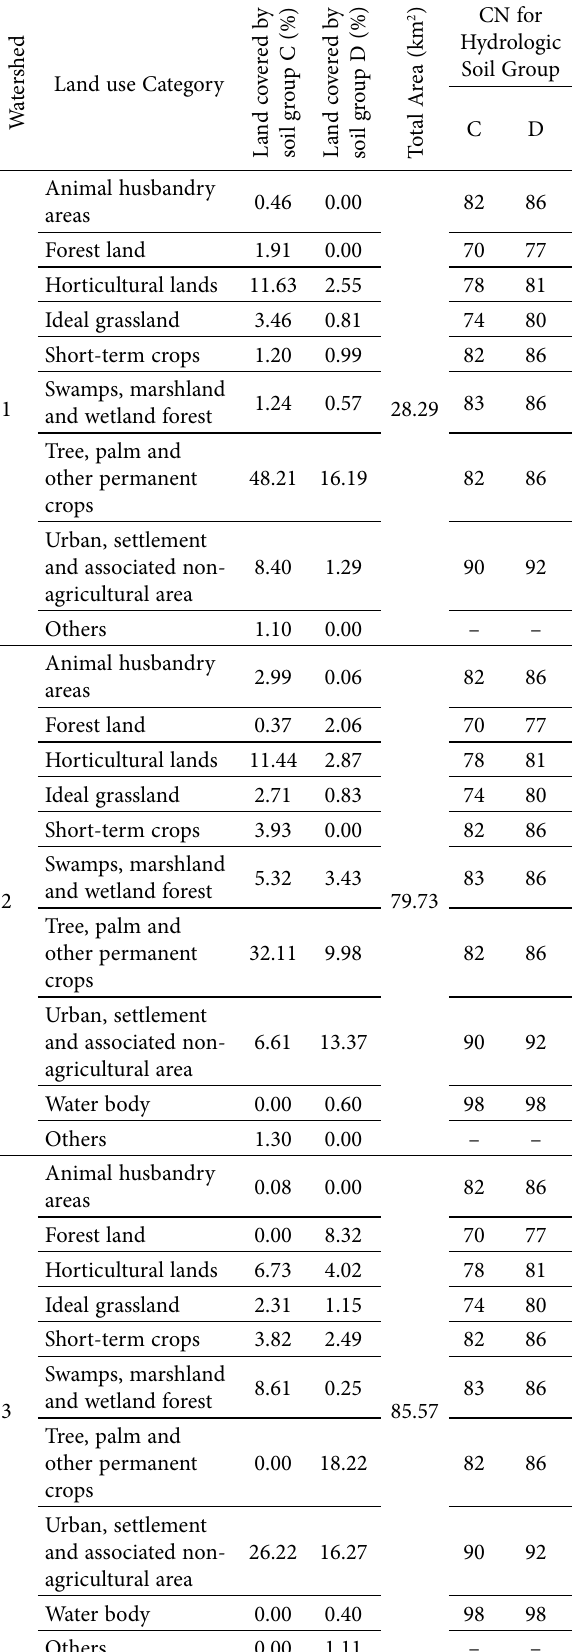
r Land use Category t e W a